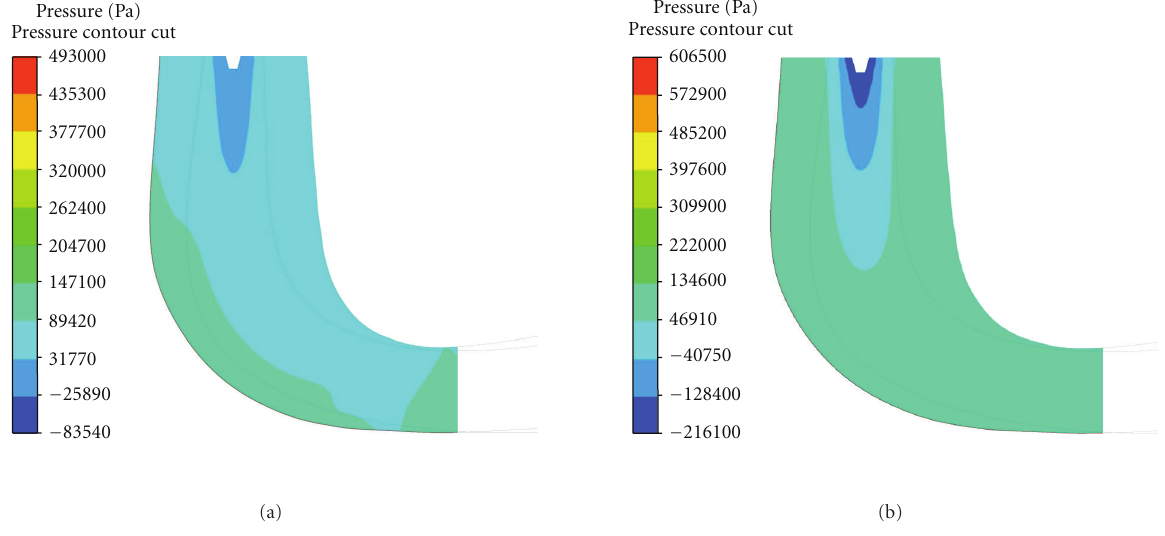
Figure 10: Pressure contours in cross-section at di ff erent flow rates (a) 76.14 m 3 /s and (b) 89m 3